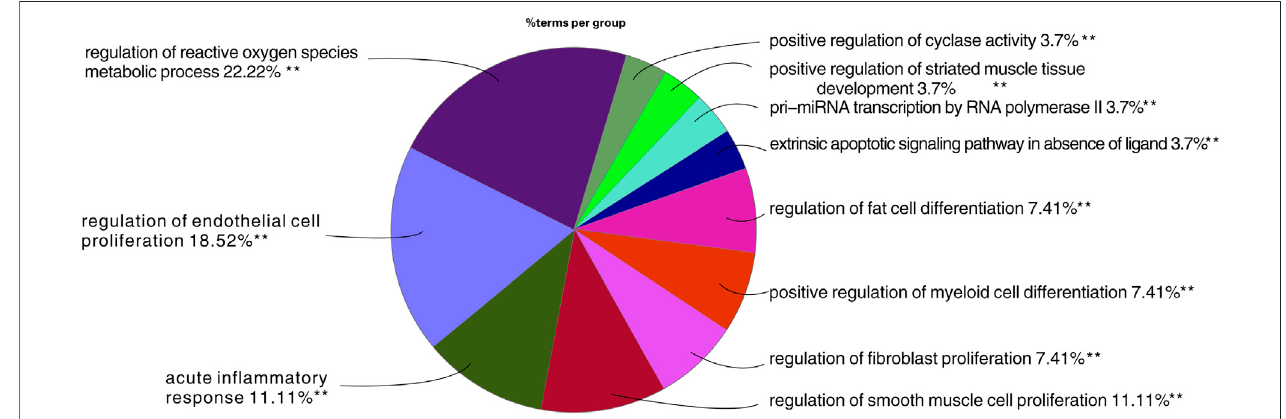
FIGURE 5 | Results of GO analysis TW treating DN. The larger the area in the fi gure, the more mapping targets clustered to this biological function.